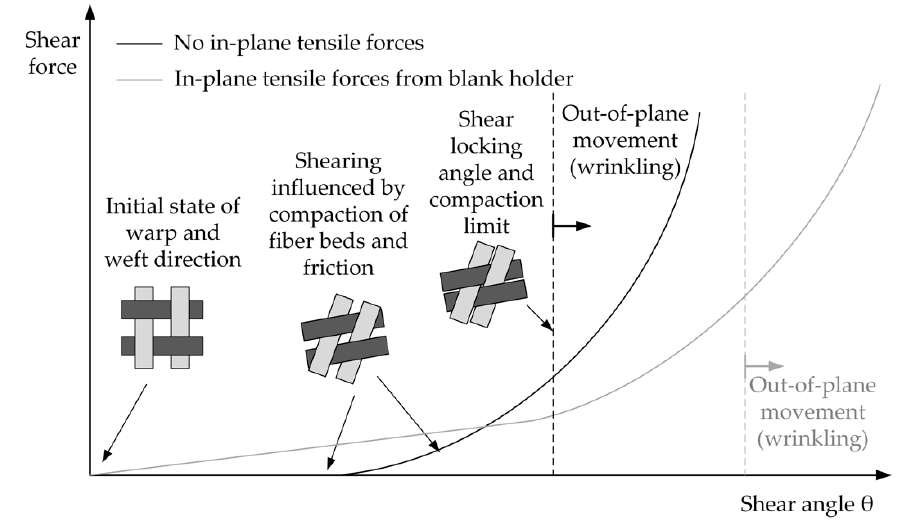
Figure 20. Shear force vs. shear angle plot of a picture frame test showing shear locking (trellis effect) with resulting increased load and out-of-plane movement in form of wrinkling.